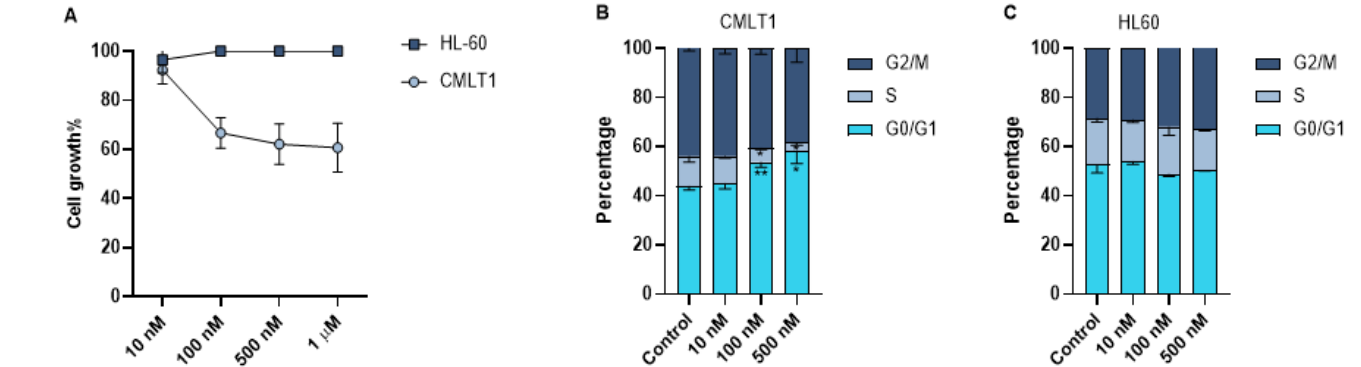
Figure 5. Cell growth assay and cell cycle analysis. Treatment with different concentrations of IL-VX starting from 100 nM to 1 µM could significantly decrease cell growth in CD26+ CMLT1 cells while it did not affect cell growth of CD26 − HL60 cells ( A ). Meanwhile, cell cycle analysis confirmed the cell growth experiment, and an arrest in G0/G1 was seen in CMLT1 ( B ). Cell cycle remained unchanged in CD26 − HL60 cells ( C ). (* p < 0.05, and ** p < 0.01).